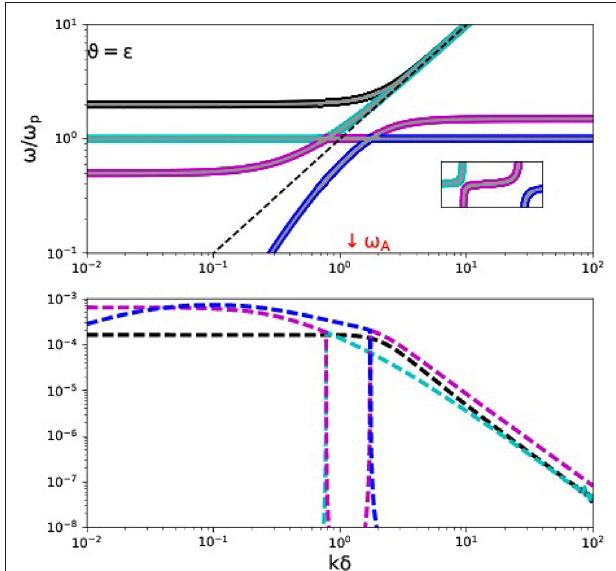
FIGURE 9 | Comparing the Appleton-Hartree approximation to the actual hydrogen ion-electron plasma dispersion diagram for E 1.5, at a = near-parallel orientation ( ϑ 0.001). The top panel shows the branches ( ω A is = off the scale shown) as in Figure 3 (left panel) in the same color scheme, while the gray lines that are overplotted correspond to the 4 modes of the Appleton-Hartree approximation. The inset shows their agreement near the avoided crossings. The bottom panel quantifies their difference: this is largest at small